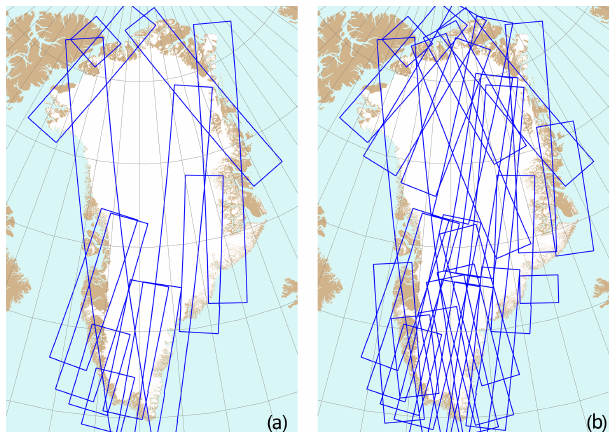
Figure 2. Typical Sentinel-1 coverage over Greenland for a single 12d orbital cycle (a) during the standard observation scenario and (b) during the dedicated winter campaign from December 2019– February 2020. The blue polygons represent acquisitions from dif- ferent tracks, acquired at different times during the